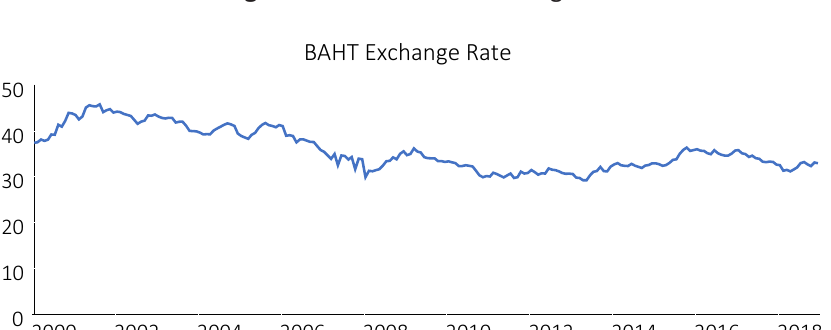
Figure 1. The SET index during 2000–2018